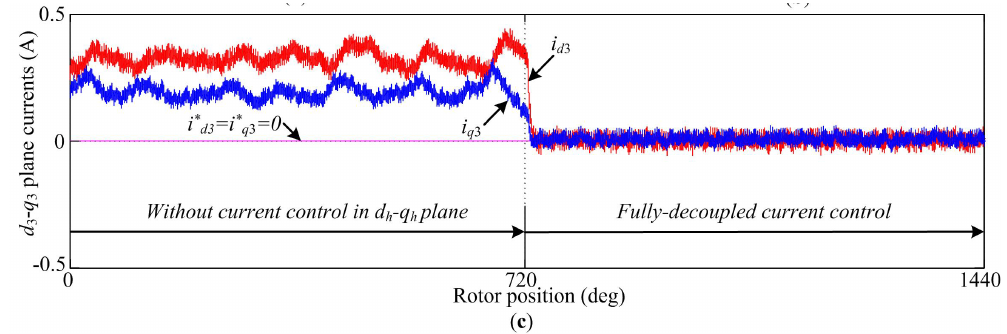
Figure 7. Simulation evaluation of steady-state performance. ( a ) Without current control in the d h - q h plane; ( b ) Fully-decoupled current control; ( c ) Steady-state current errors in d 3 - q 3 plane.